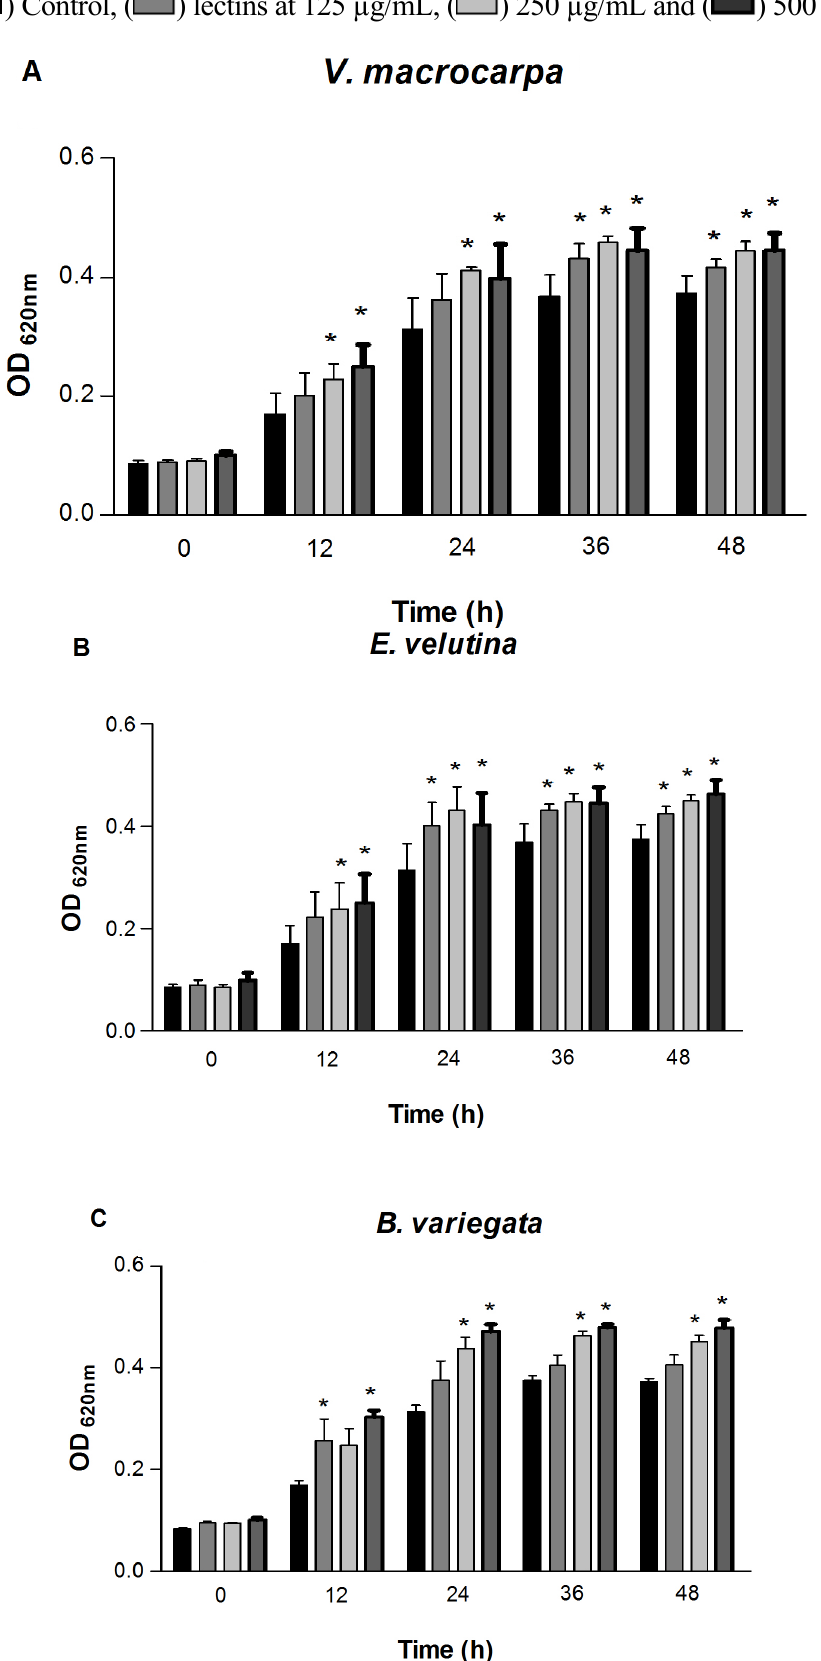
Figure 3. Effect of D -galactose-specific lectins on the growth of R. tropici . ( A ) VML, ( B ) EVL and ( C ) BVL. * p < 0.01 relative to control. Error bars indicate the standard deviation of the means.